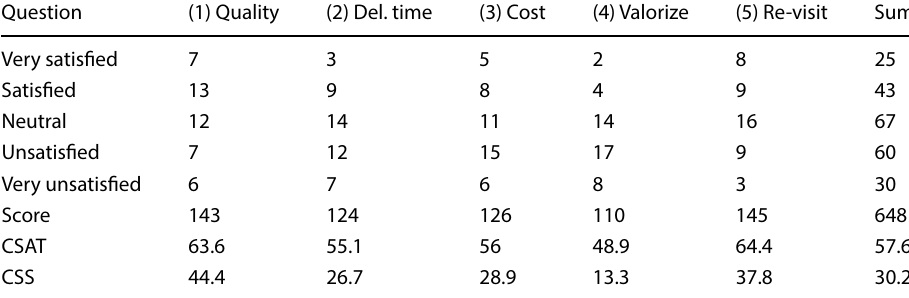
Table 18 The customer satisfaction measurement for group 1 (without need